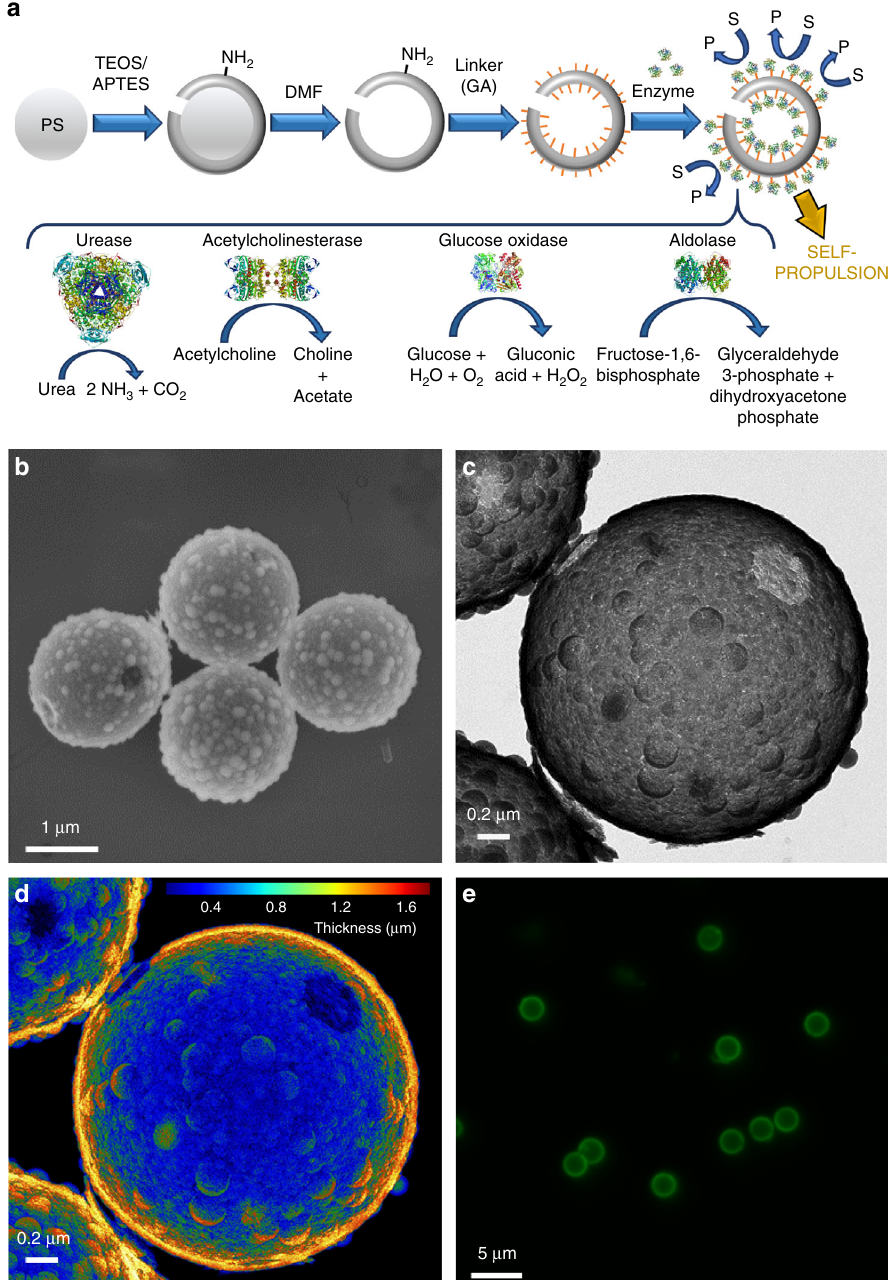
Fig. 1 Fabrication and characterization of hollow silica micromotors. a Schematic representation of the fabrication process of HSMC functionalized with enzymes to obtain HSMM that catalyze substrates (S) into products (P) resulting in self-propulsion. PS: polystyrene, TEOS: tetraethylorthosilicate, APTES: 3-aminopropyltriethoxysilane, DMF: dimethylformamide, GA: glutaraldehyde. Enzyme structures are extracted from RCSB PDB (see Supplementary Note 3). b SEM and c TEM image of HSMC showing the hole and silica bulks. d False color TEM image showing HSMC thickness. e Fluorescence (Ex/Em = 520/580nm) of enzymatic HSMM treated with Krypton ™ protein staining